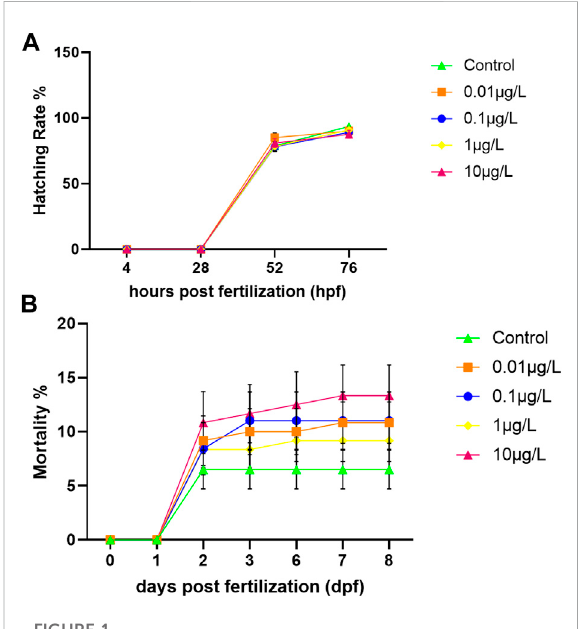
FIGURE 1 Developmental exposure to different concentrations of Sertraline. (A) Hatching rate (%) of control and exposed embryos, recorded daily for 72 h. (B) Accumulated mortality of control and exposed embryos/larvae, recorded daily throughout the exposure period. Values represented are mean ± standard error (SE). No statistical differences were observed ( n = 120) (Tukey post